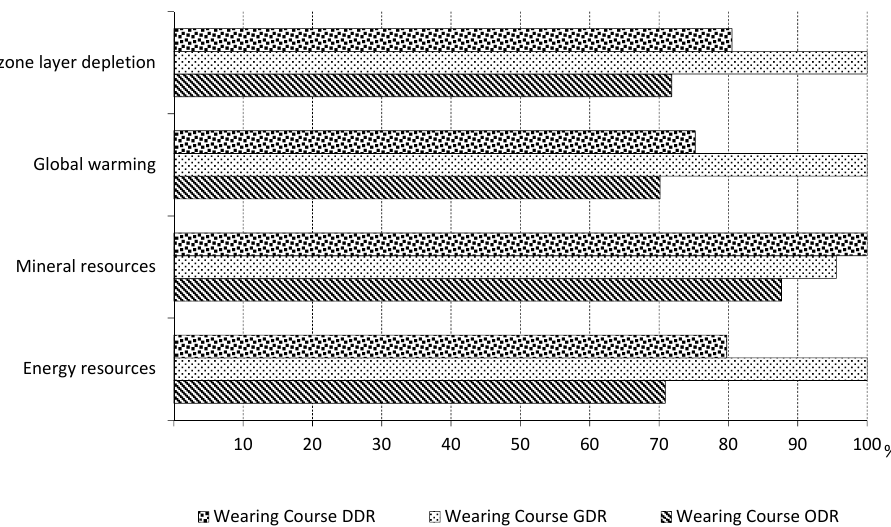
Figure 7. Comparison between dry rubberized wearing courses.